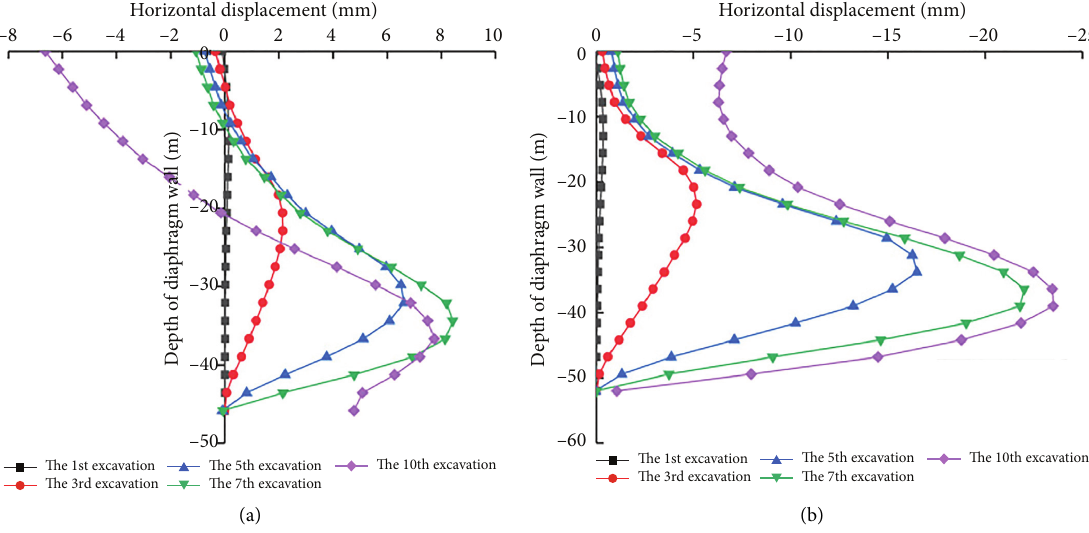
Figure 15: The horizontal displacement curve of the suspended foot diaphragm wall. (a) West wall. (b) East wall. Table 7: Summary table of the corresponding depth of the maximum horizontal displacement of the suspended foot diaphragm wall. Working procedure